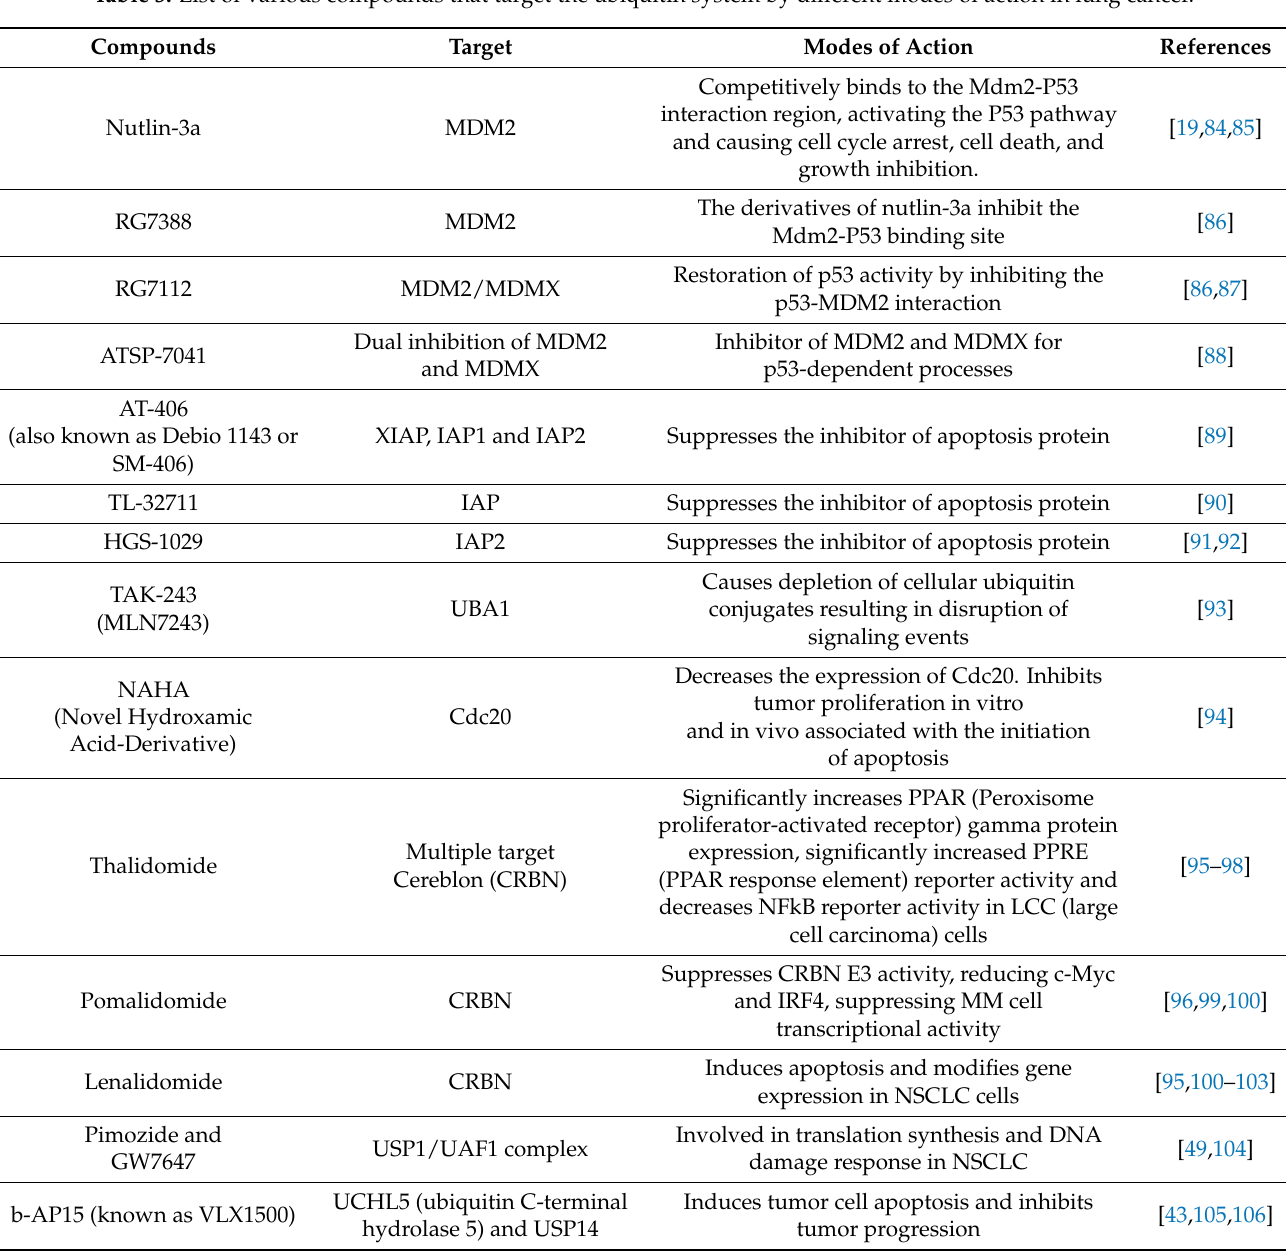
Table 3. List of various compounds that target the ubiquitin system by different modes of action in lung cancer.